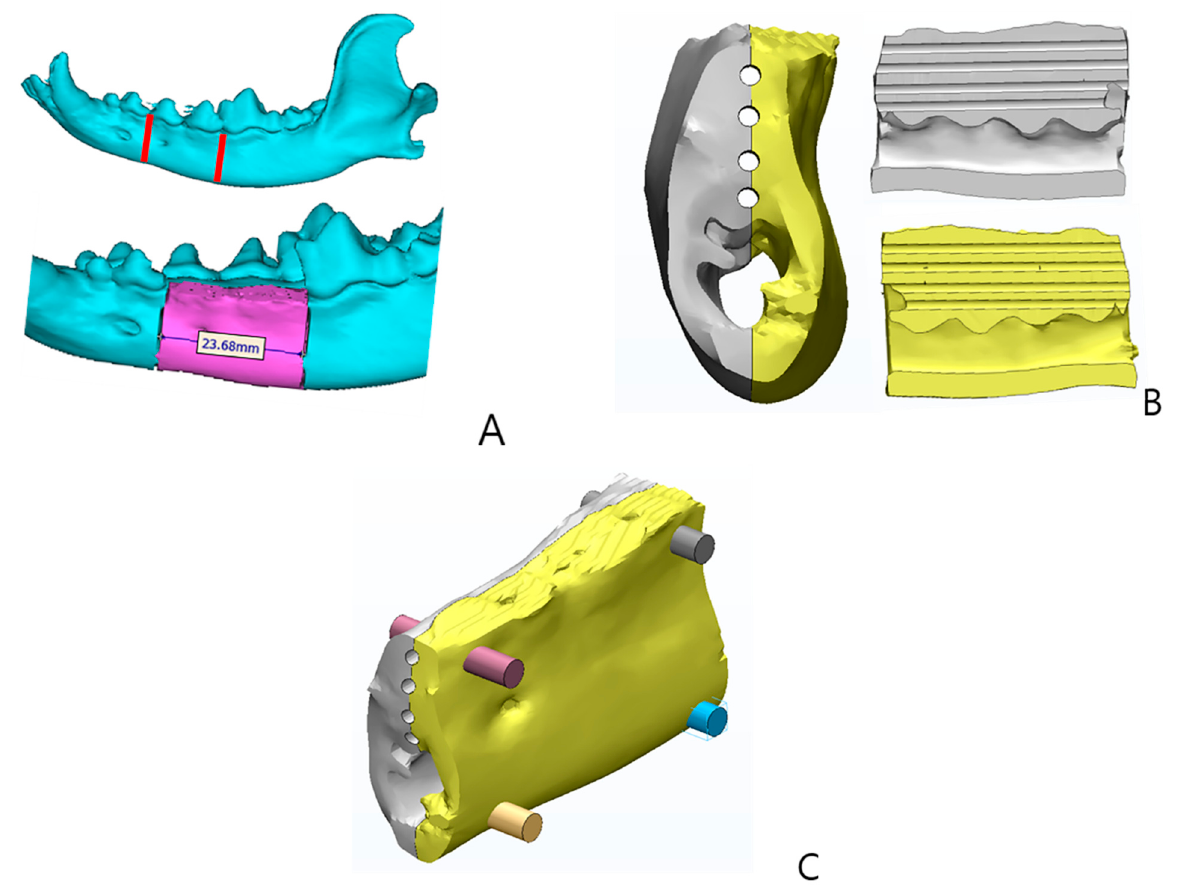
Figure 7. 3D Plotter system. ( A ) Scaffold design, ( B ) PCL/TCP/bdECM 3D printing model (4 holes diameter 1 mm), ( C ) 4 point fixation using PCL + TCP